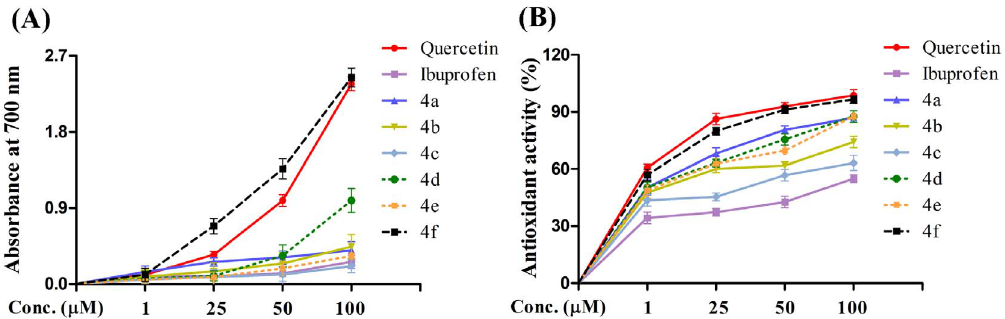
Figure 2. Efficacy of Ibuprofen and its derivatives measured in terms of (A) Reduction potential (B) DPPH radical scavenging activity in comparison with Quercetin. Values are presented as mean 6 SEM (n=5).